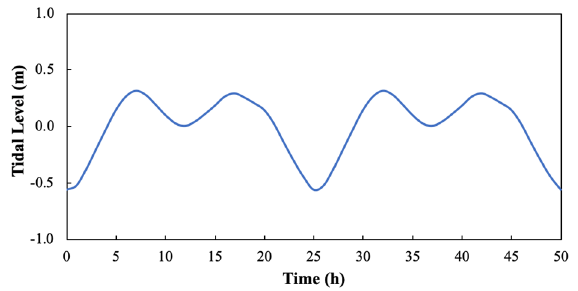
Figure 2. The observed tidal level over two continuous tidal cycles at the Xinkaikou tide station in 2017.